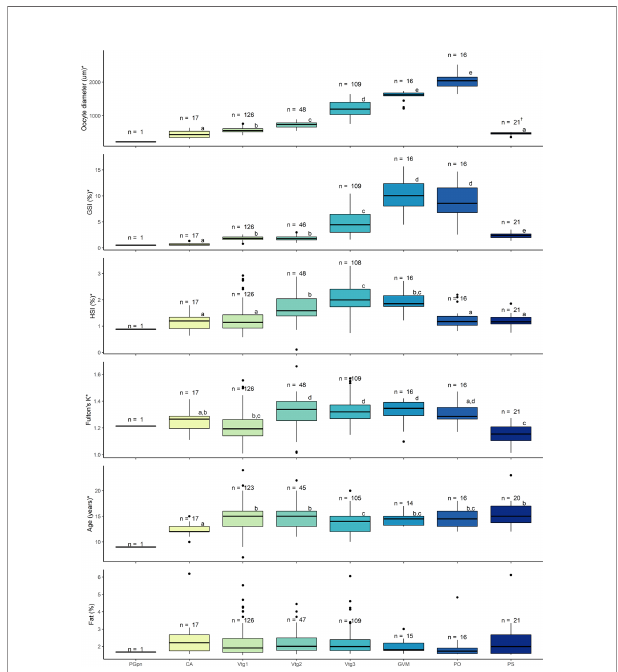
FIGURE 5 | Oocyte size (diameter in µm), gonadosomatic index (GSI, %), hepatosomatic index (HSI, %), Fulton ’ s condition factor (K), age (years), and somatic fat (%) of female Paci fi c halibut according to developmental stage. For each parameter, statistical signi fi cance (p < 0.05, Kruskal-Wallis) was denoted with an * in the y-axis title, with different letters indicating statistically signi fi cant (p < 0.05, Dunn ’ s post hoc ) differences among groups (e.g. “ a ” is different from “ b ” but not from “ ab ” ), and with the sample size displayed above the boxes. PS stage, denoted by † is identi fi ed by the presence of POFs and, therefore, the oocyte diameters are representative of the CA oocytes which in this case only are not the most advanced